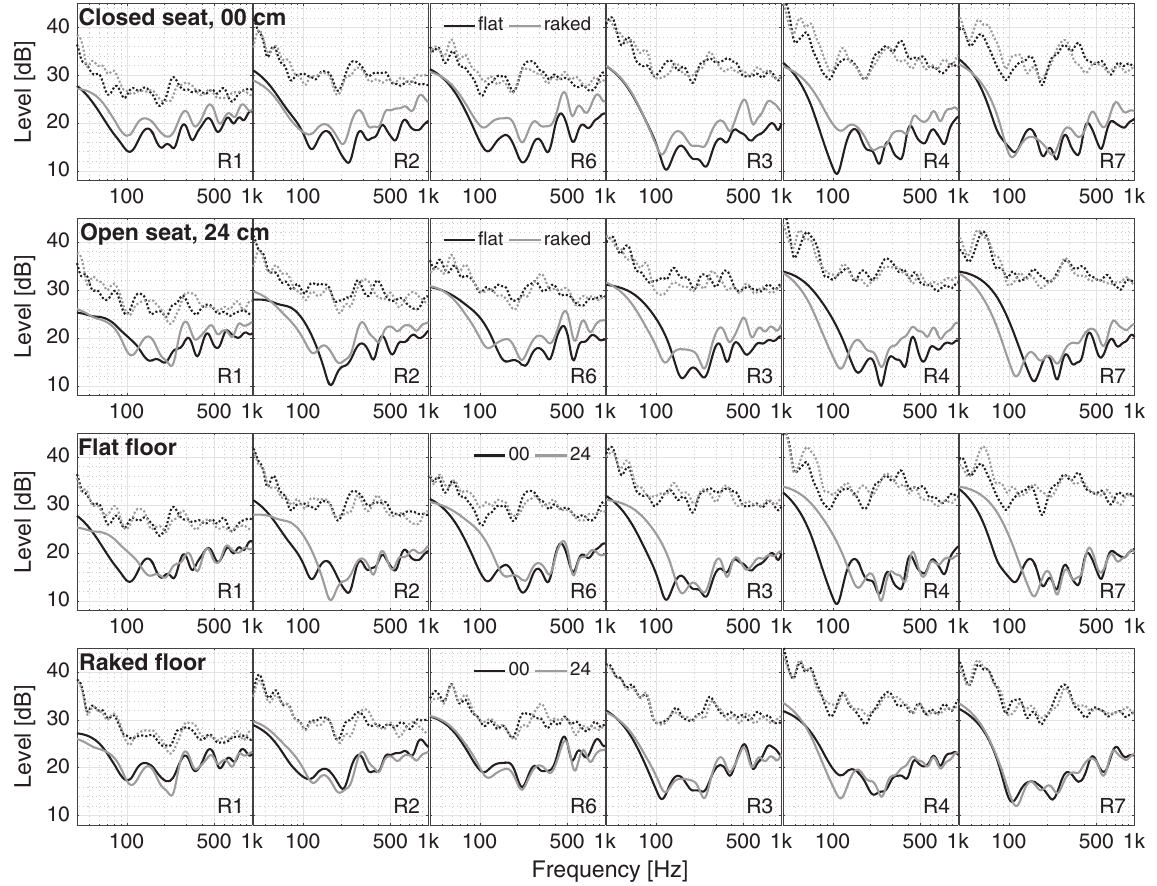
Figure 7. The 15 ms (solid) and 500 ms (dotted) magnitude responses of the different seat and fl oor types measured with the box. The responses are 1/3 octave smoothed.